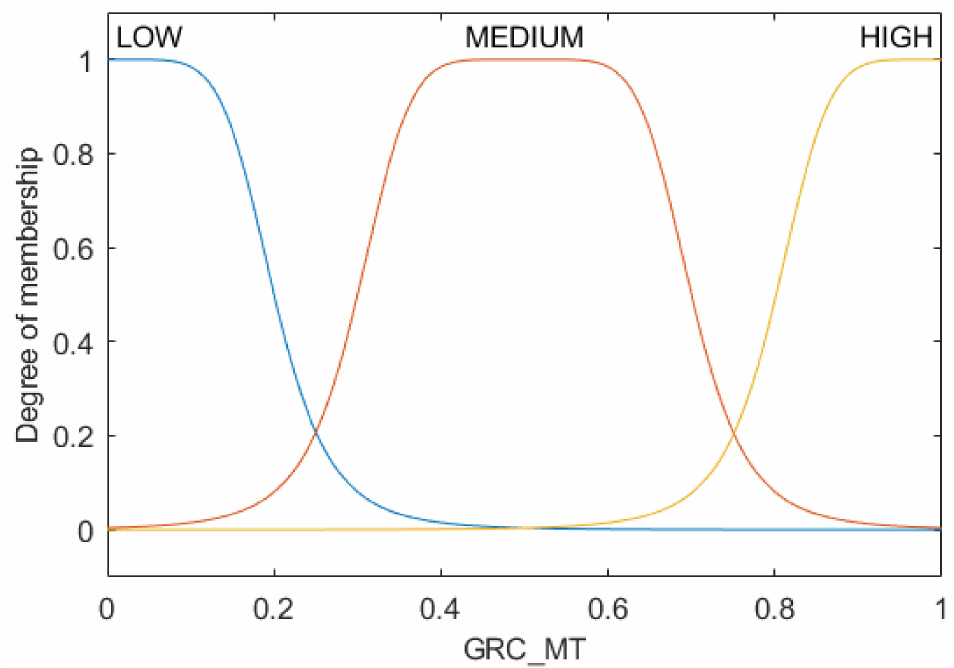
Figure 5. Example of Gbell membership function of GRC for MT.